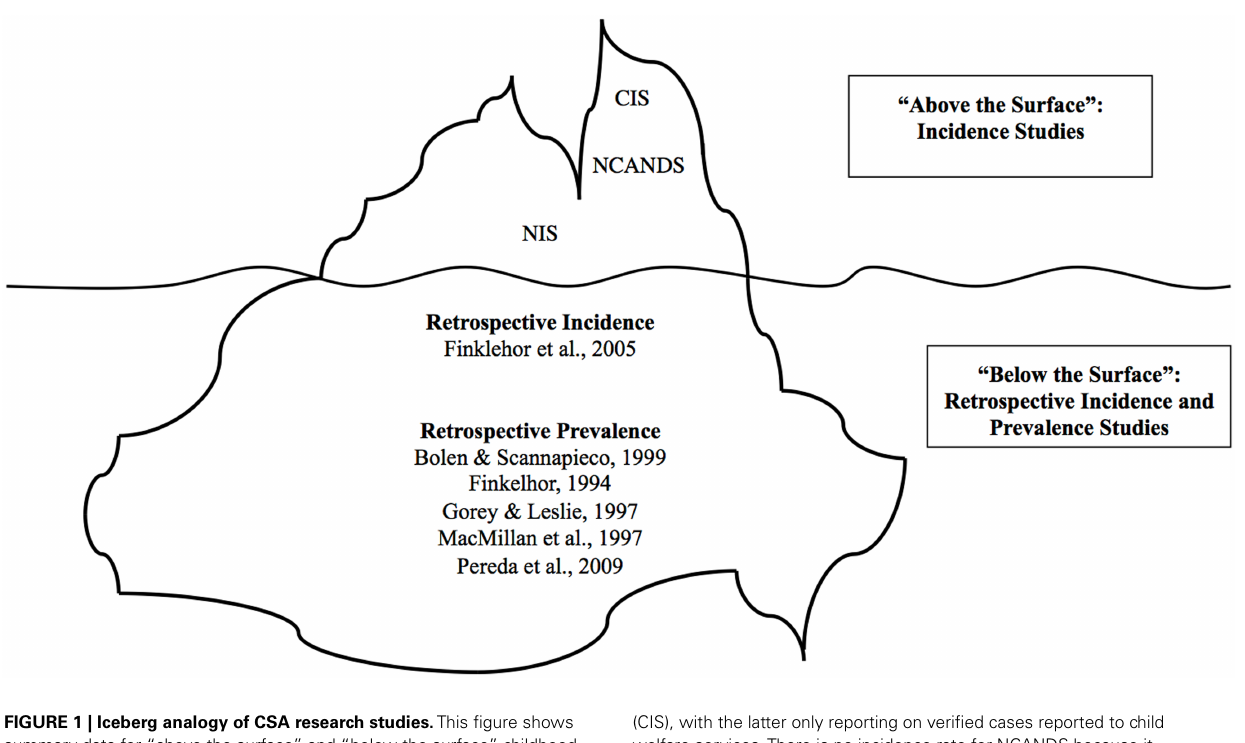
FIGURE 1 | Iceberg analogy of CSA research studies. This figure shows summary data for “above the surface” and “below the surface” childhood sexual abuse (CSA). Incidence rates for both the United States in the National Incidence Studies (NIS) and for the Canadian Incidence Studies